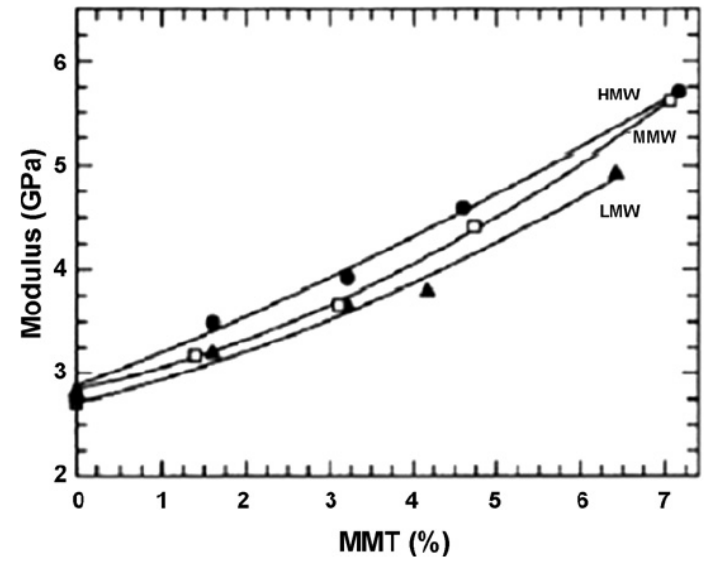
Figure 33. Increase in the tensile modulus as a function of the amount of montmorillonite fraction. Three matrices with low, medium and high molecular weights are depicted.